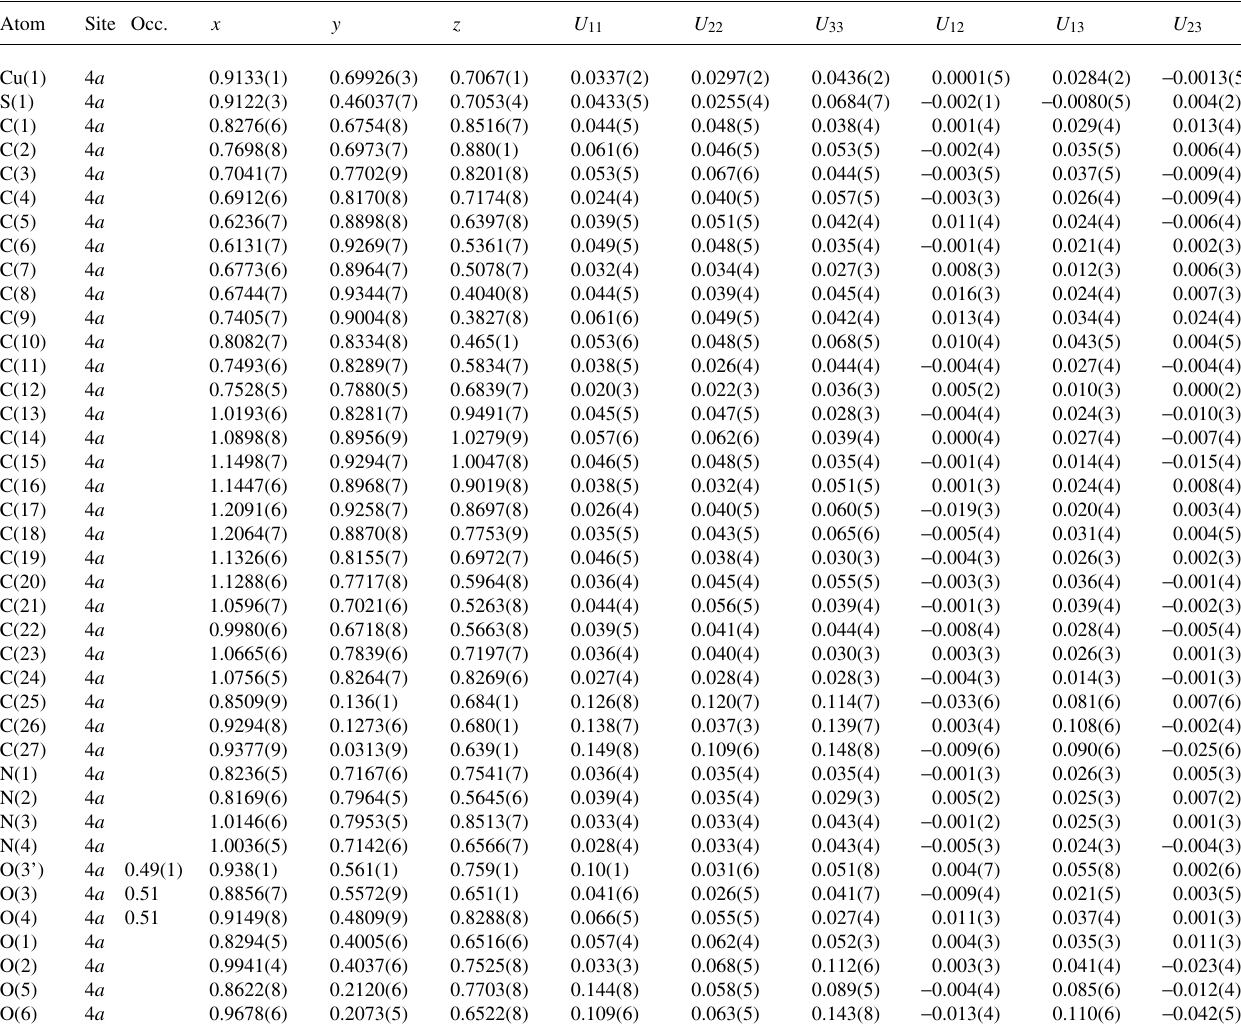
Table 3. Atomic coordinates and displacement parameters (in Å 2 ) . Atom Site